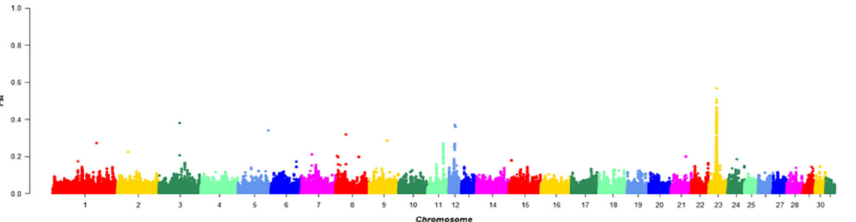
Figure 5. Manhattan plot of the F ST values between the Chakouyi horses and other horses worldwide. The F ST values are calculated for each 20 kb autosomal window. Adjacent chromosomes were indicated with different colors to make a better distinction of their borders.